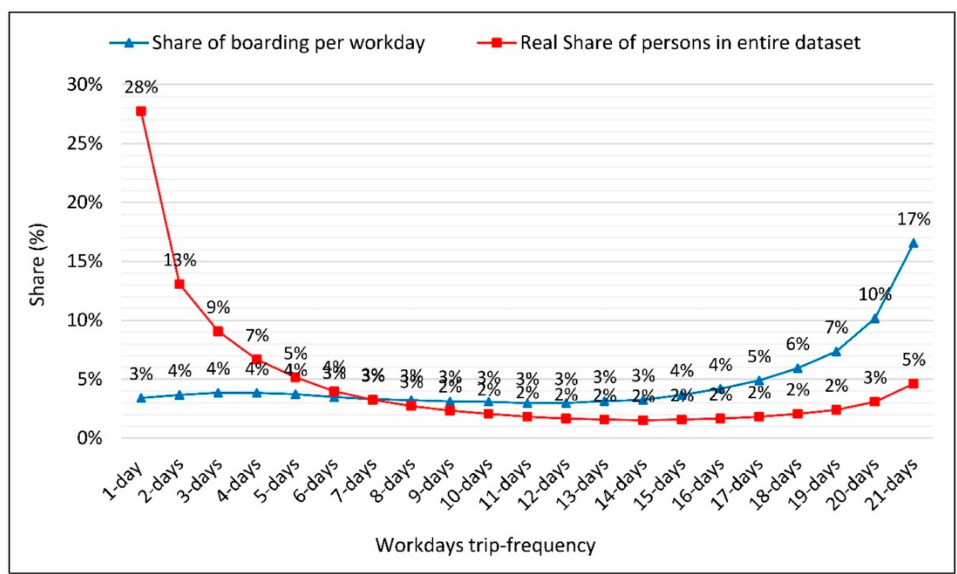
Figure 5. Share of boarding per workdays (blue) vs. real share of persons (red) in entire dataset. To highlight how frequency-based user group boardings and cardholder share can be over/under representing (over-weighting and under-weighting) more clearly, the division of the real share of each group in single-month data for workdays is shown in Figure 6. As seen in Figure 6, groups of users with a higher frequency of use are more over- represented, while groups with a lower frequency of use are more